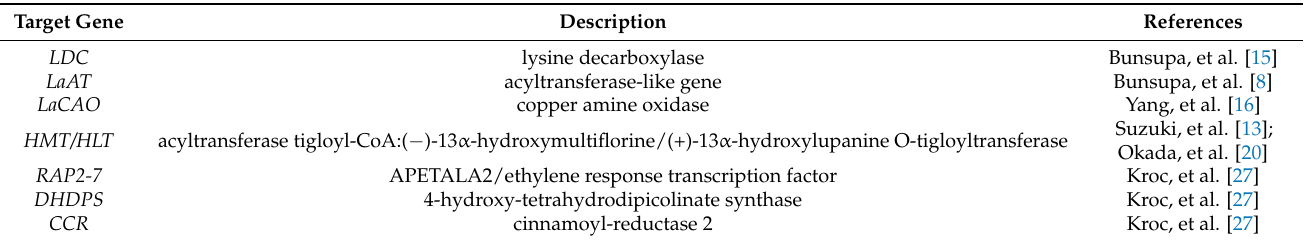
Table 1. Structural and candidate genes involved in quinolizidine alkaloids biosynthesis and accumulation in narrow-leafed lupin that were assayed by quantitative PCR (qPCR).